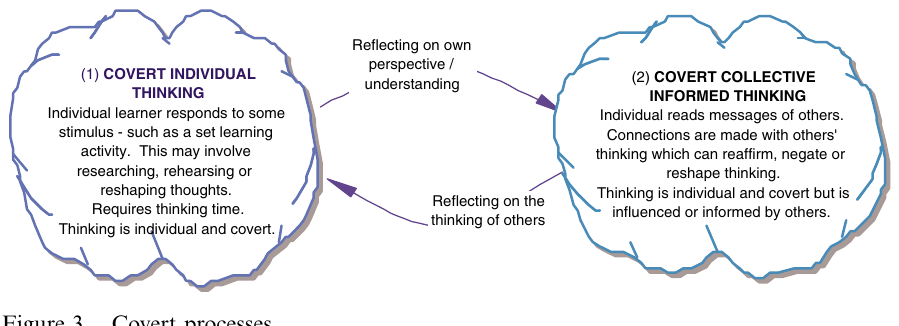
Figure 3. Covert